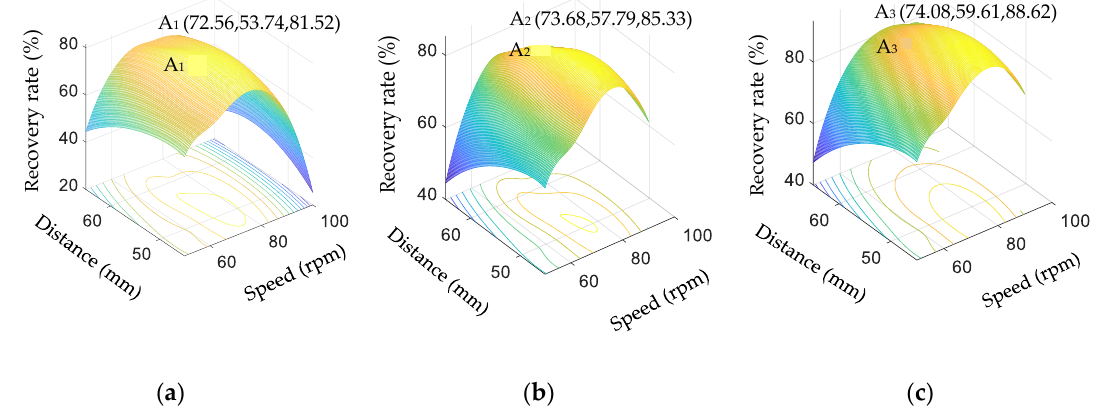
Figure 5. Effect of the conveying device ’s rotational speed (rpm) and the distance between elastic teeth (mm) on the recovery rate of PF (%) at three types of elastic teeth, ( a ) A, ( b ) B and ( c ) C.